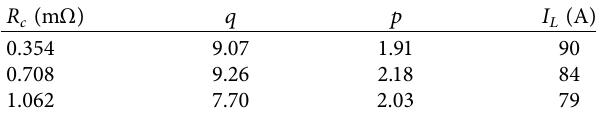
I v and ln ( v - I L ) under the L under the three work